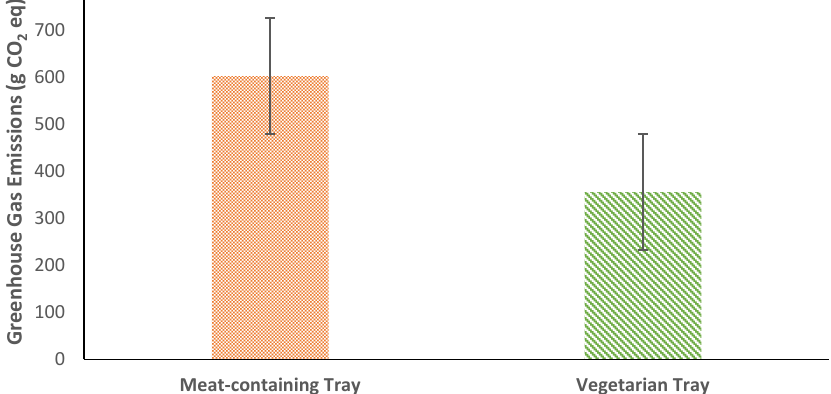
Figure 3. Mean total GHGE (g CO 2 eq) by meal type. Error bars represent the standard error of mean.